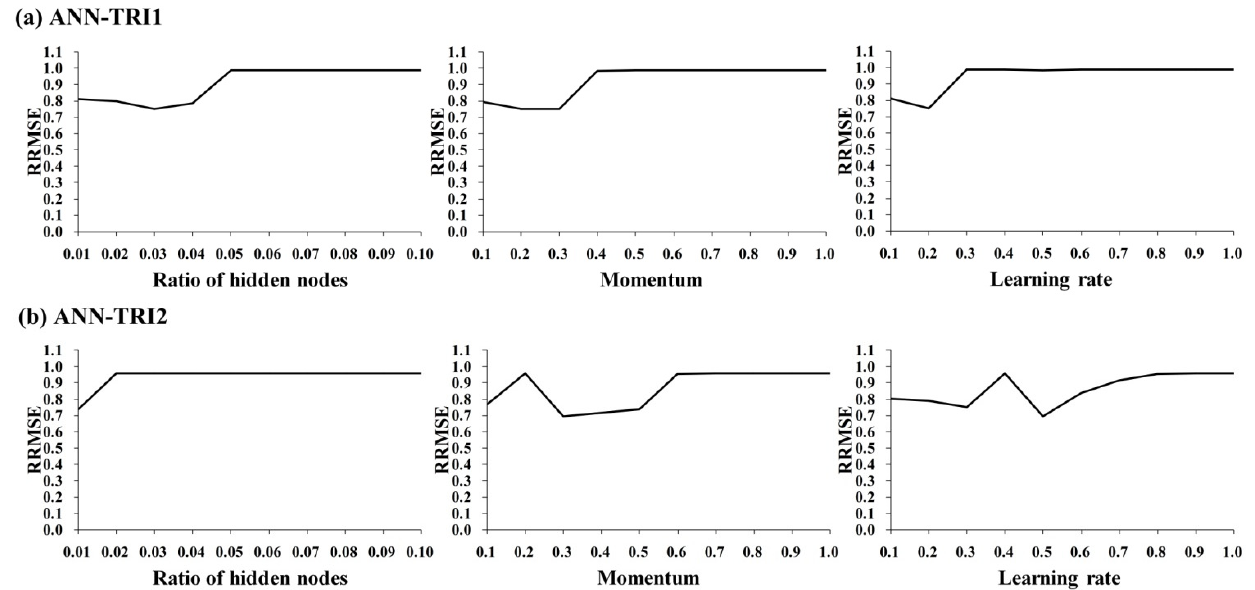
Figure 8. Sensitivity results of MLP parameters by using a validation set for two MLP ANN models based on a trial-and-error calibration method: ( a ) ANN–TRI1; and ( b )